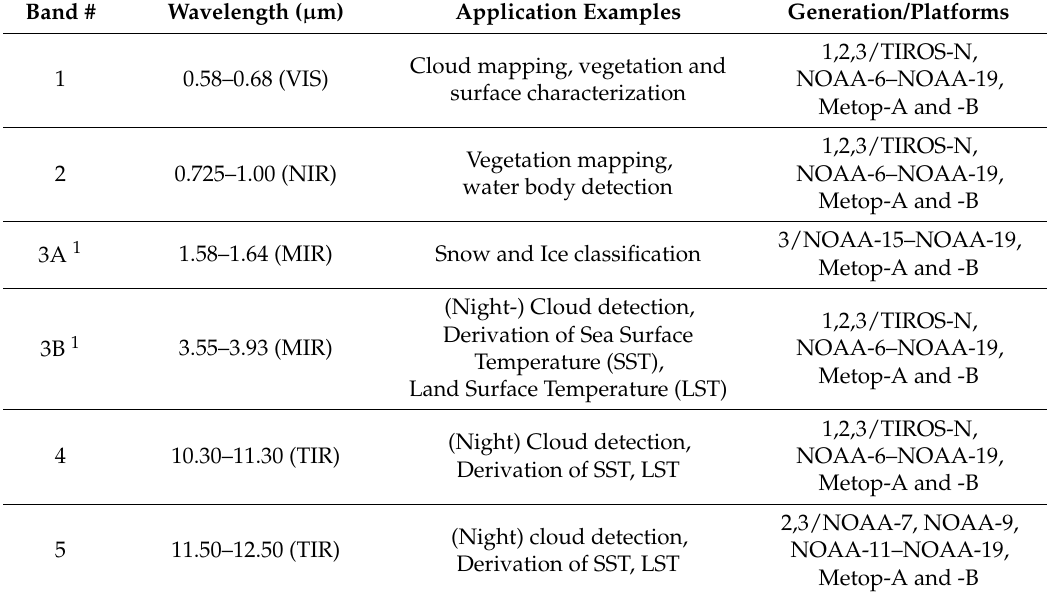
Table 1. Spectral Characteristics of AVHRR